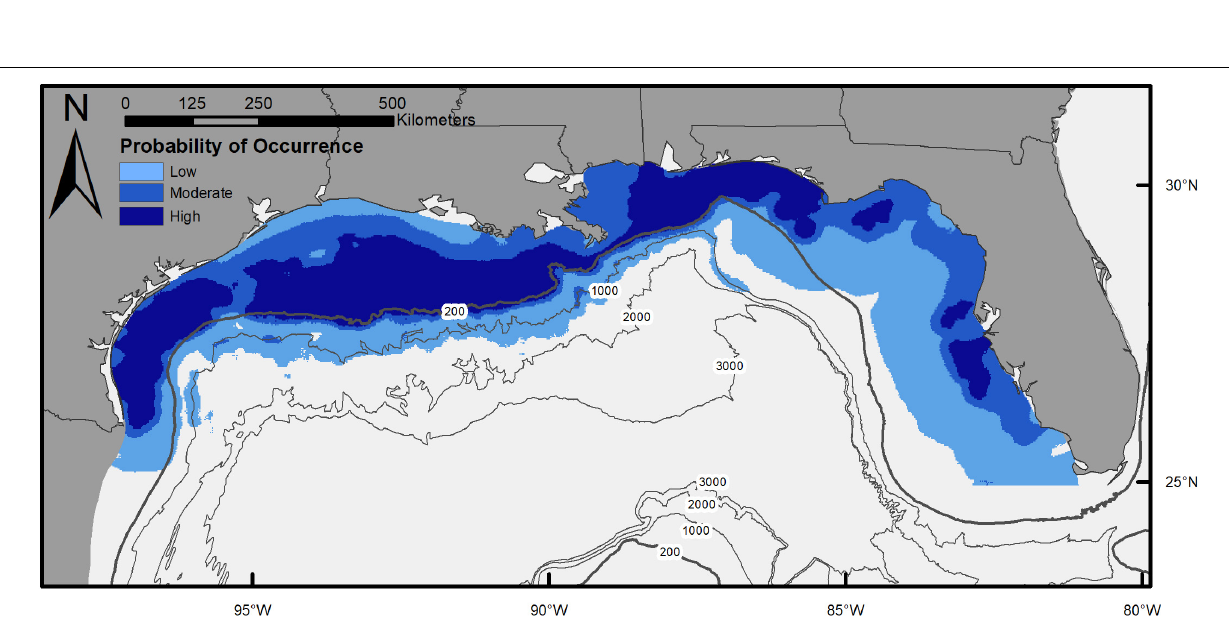
FIGURE 3 | Map of habitat suitability for scalloped hammerheads across the northern Gulf of Mexico, based on generalized additive model of shark presence–absence and environmental variables (chlorophyll a, salinity, sea surface height anomaly, depth, distance to artificial structure, and distance to hard bottom